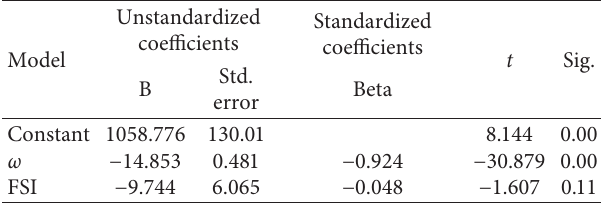
Table 2: Coefficient generated by IBM SPSS.